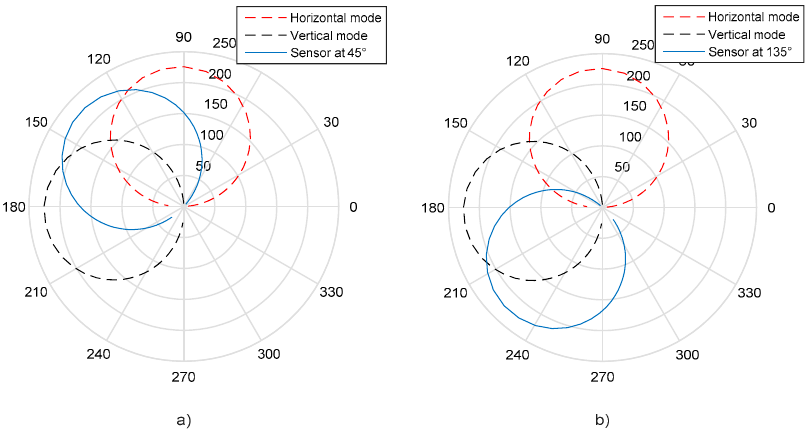
Figure 5. Polar diagram with close modes at ( a ) 45° and ( b ) 135° ( μ m ). Figure 5a and b represent the coupled mode with a red dotted line observed by a sensor at 0°, while the black dotted line is observed by a sensor at 90°, and the sensor placed at 45° and 135°, represented in blue, appears to display a single vibration mode.